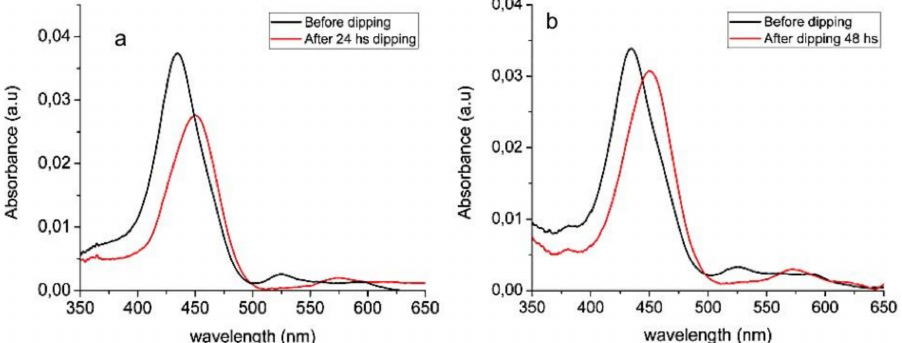
Figure 8. UV–Vis spectra of glass slides functionalized with H2T4 before (black line) and after (red line) immersion in DI water containing Zn 2 + ions released by ZnO / PES mats dipped in water for ( a ) 24 h and ( b ) 48